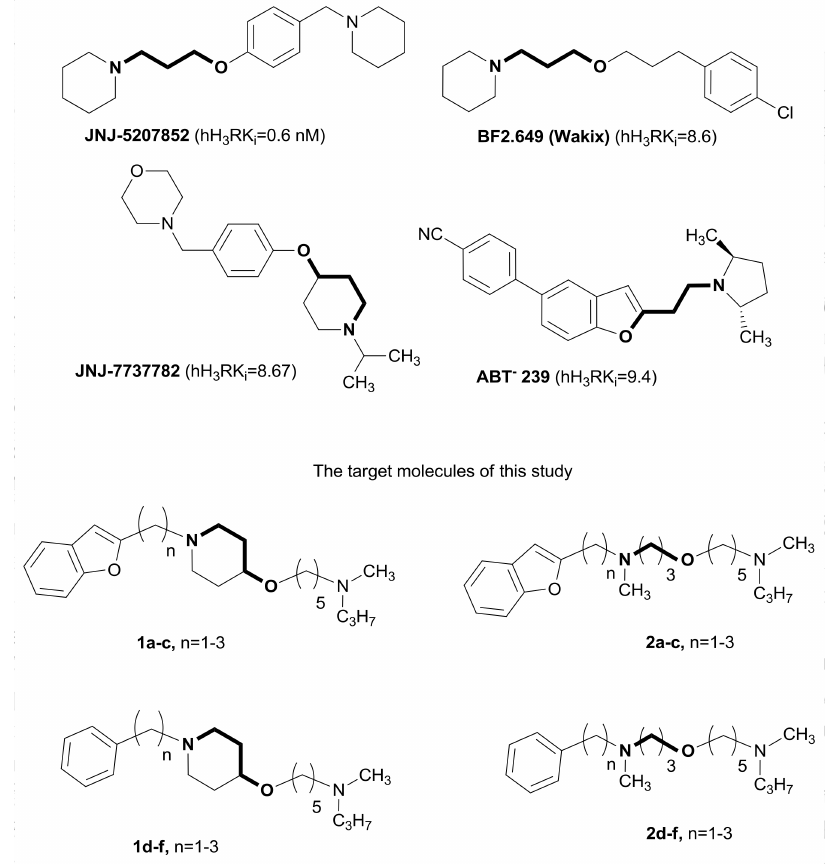
Figure 1. Representative non-imidazole H 3 -histamine receptor antagonists containing the characteristic 3-aminopropan-1-ol functionality, its rigid analogues, and the target molecules of this